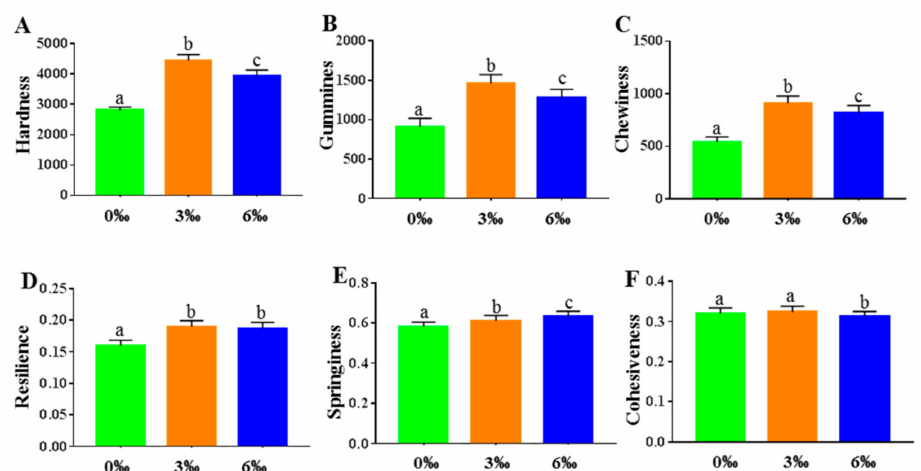
Figure 3. Results of texture-profile analysis of muscle of grass carp cultured at different salinities (0‰, 3‰, and 6‰). ( A ), Hardness; ( B ), Gumminess; ( C ), Chewiness; ( D ), Resilience; ( E ), Springiness; ( F ), Cohesiveness. Different lowercase letters indicate significant differences among different salinities ( p < 0.05).